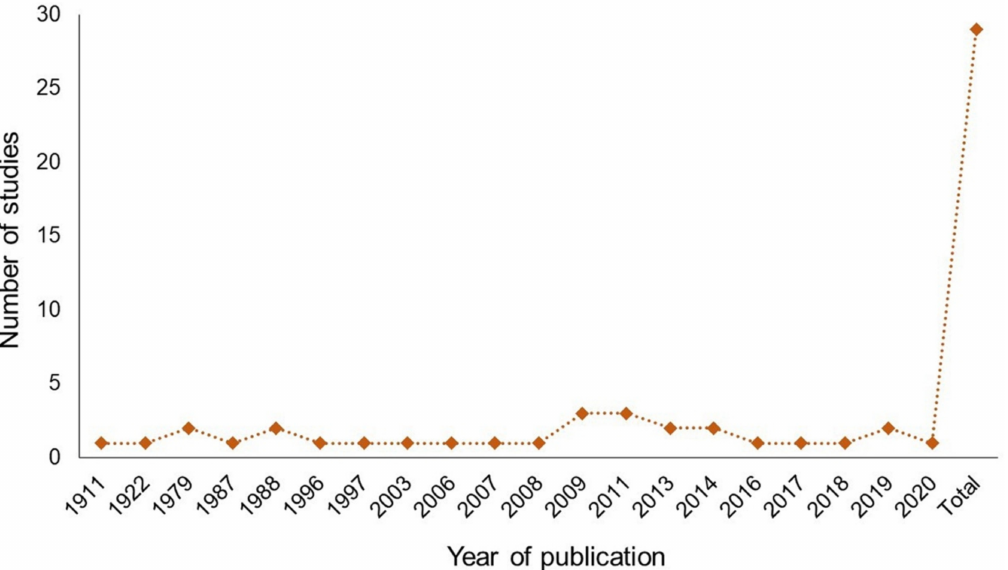
Figure 1. Number of retrieved articles from search in three academic databases about flower-visiting insects associated with Opuntia species, published from 1911 to 2020 worldwide. Note the discontinu- ity in the years of publication.